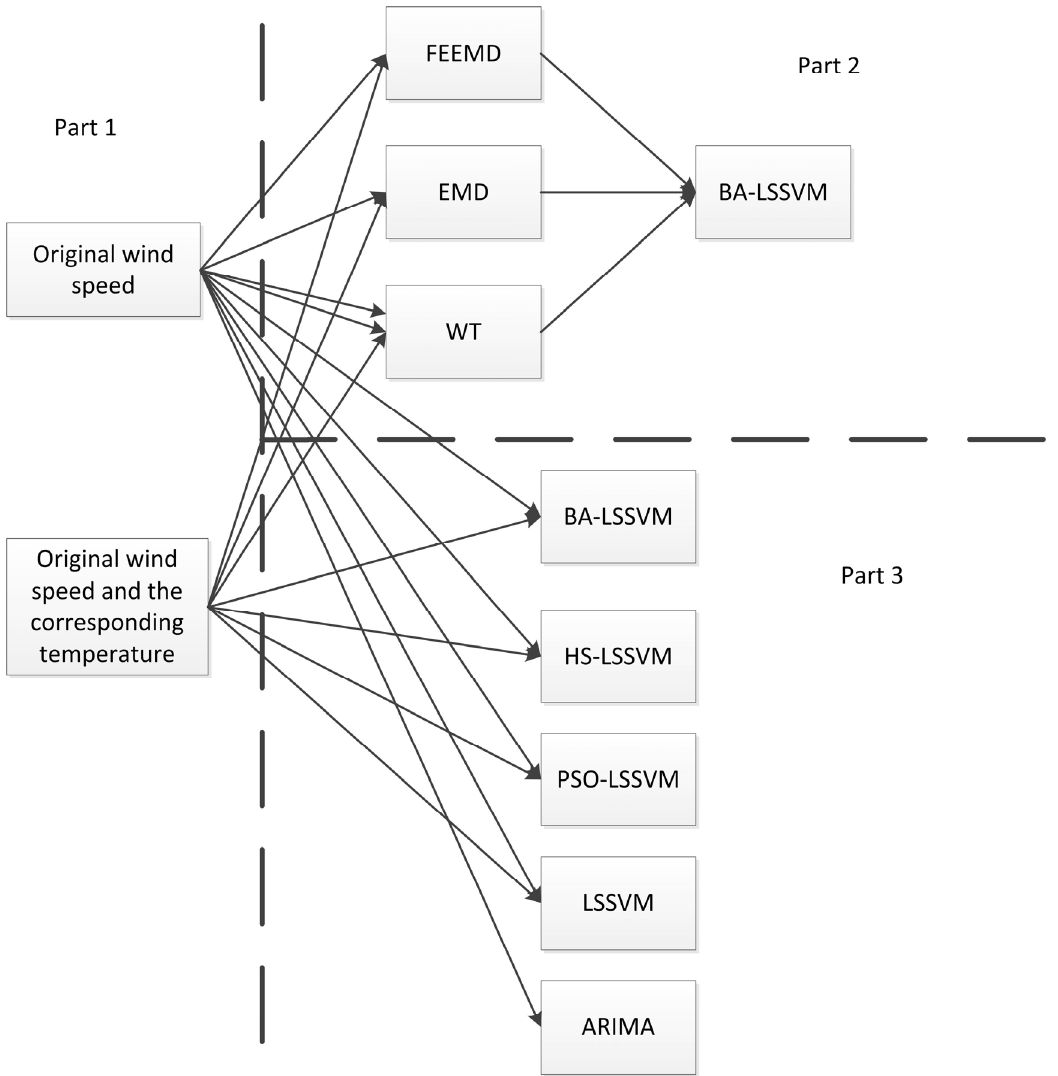
Figure 10. Framework of the comparative analysis.